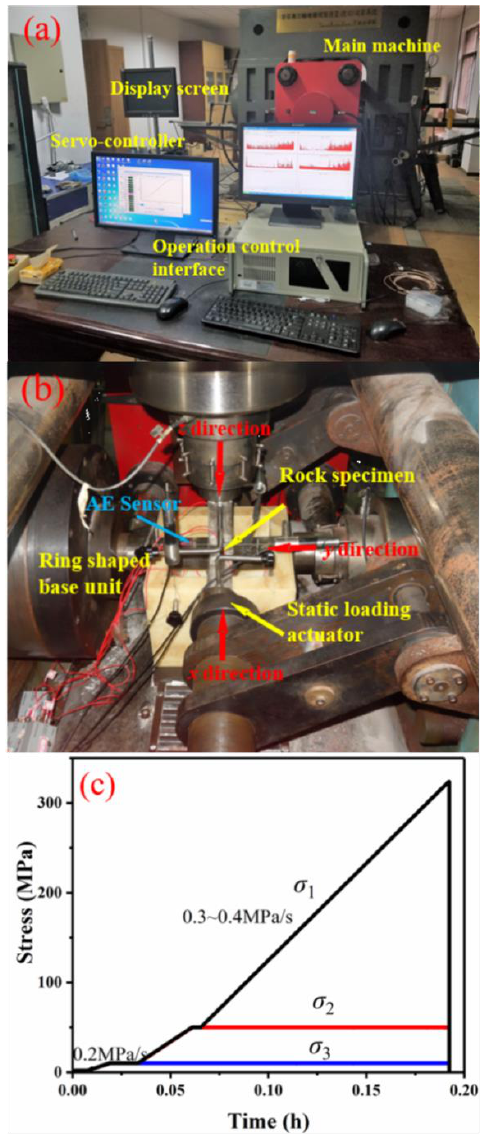
Figure 1. Illustration of the true triaxial test system: ( a ) an overview of the testing system; ( b ) image of the true triaxial machine and the designed loading apparatus; and ( c ) representative loading path. AE in the figure represents acoustic emission.